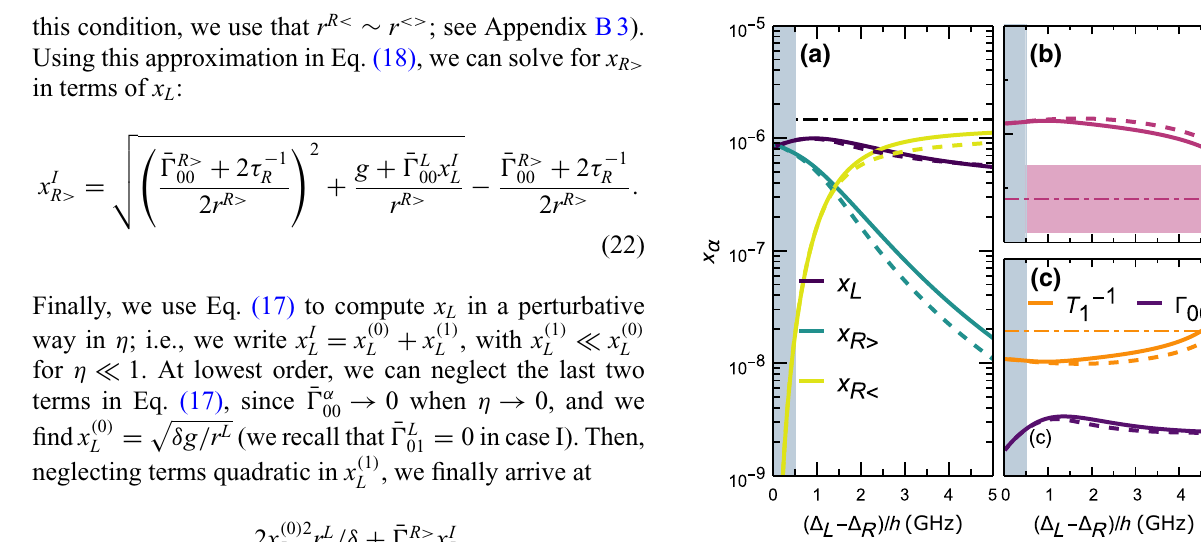
Fig. 1 of Ref. [35,61]. The quasiparticle densities obtained through numerical solution of Eqs. (9) and (11)–(13) (solid